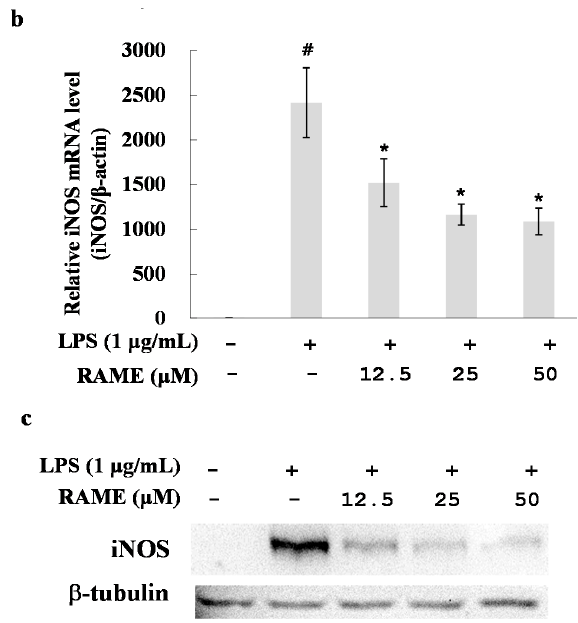
Figure 2. Effects of RAME on NO production and iNOS expression levels in RAW 264.7 cells. RAW 264.7 cells were treated with various concentrations of RAME for 2 h prior to incubation with LPS (1 μ g/mL) for 18 h. ( a ) Inhibition of NO production; ( b ) mRNA expression levels of iNOS measured by real-time PCR; ( c ) Protein expression levels of iNOS measured by Western blot. # p < 0.05 vs. control group , * p < 0.05 vs. LPS-treated.